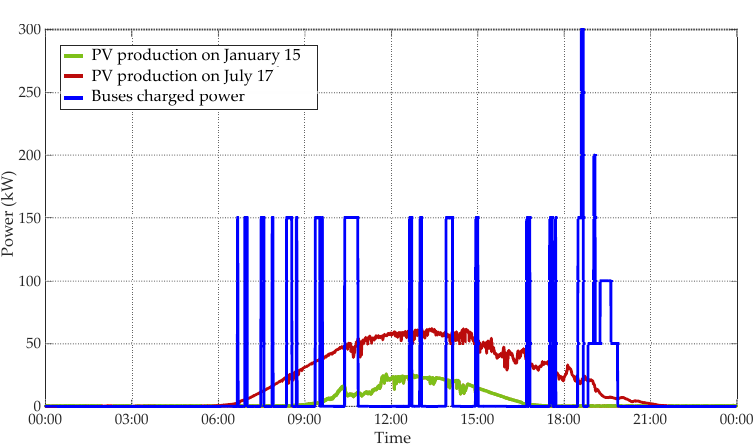
Figure 11. Total charging power and PV production over time—scenario